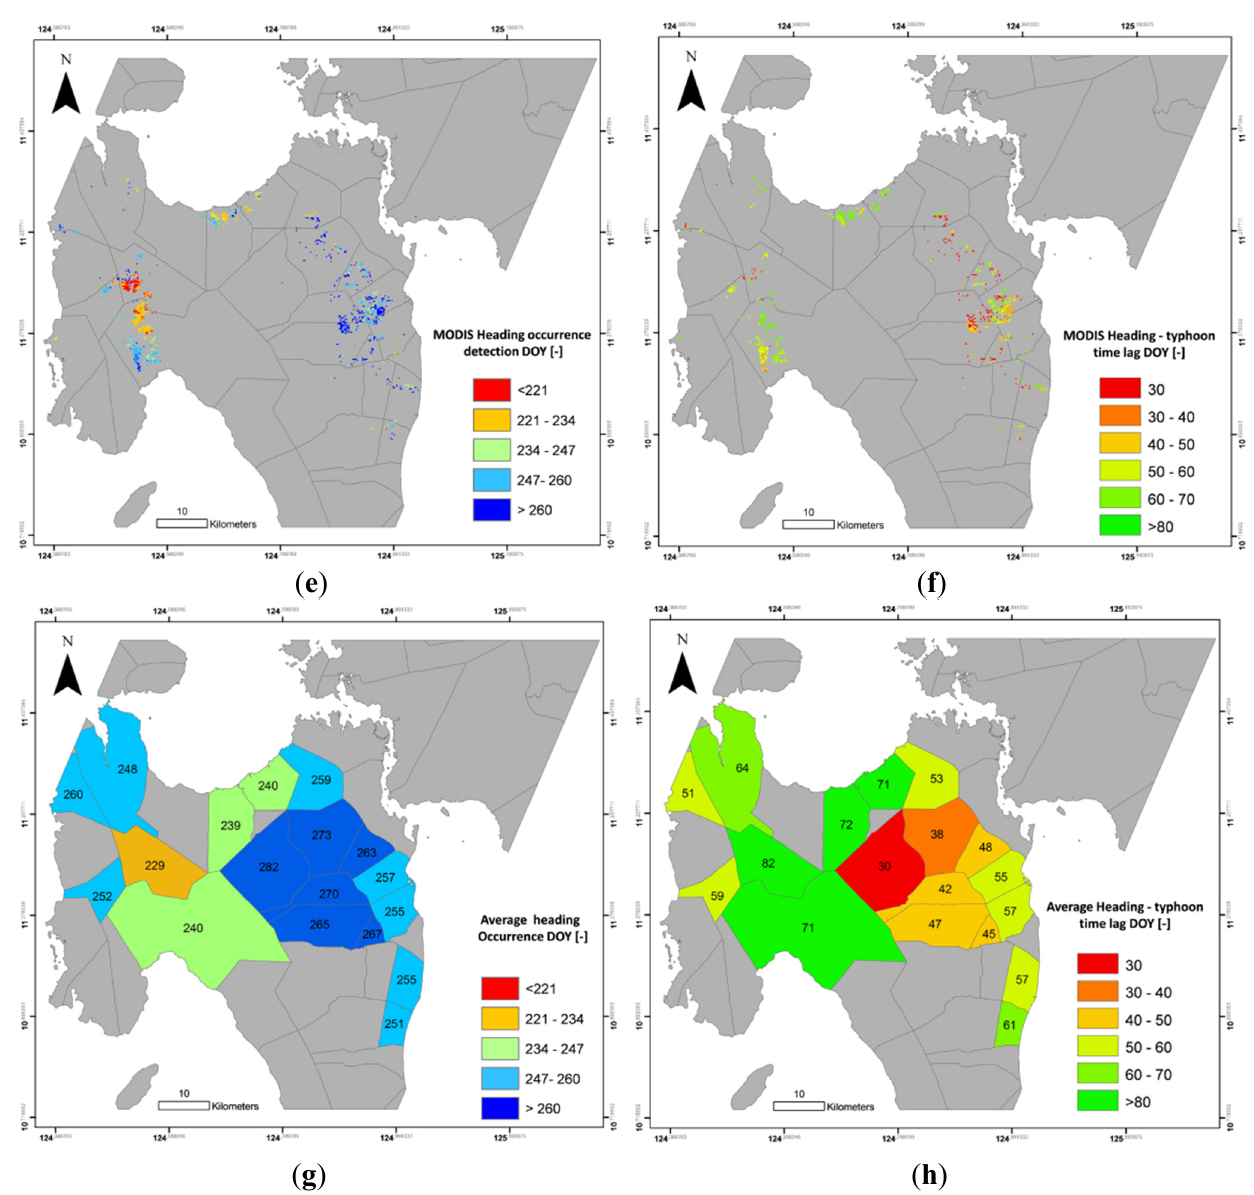
Figure 8. ( a ) Rice cultivated area from SAR; ( b ) flooded area from SAR; ( c ) rice area per municipality; ( d ) flooded area per municipality; ( e ) heading dates from MODIS; ( f ) days between heading and typhoon Haiyan per MODIS pixel; ( g ) averaged MODIS heading dates per municipality; and ( h ) average number of days between heading and typhoon